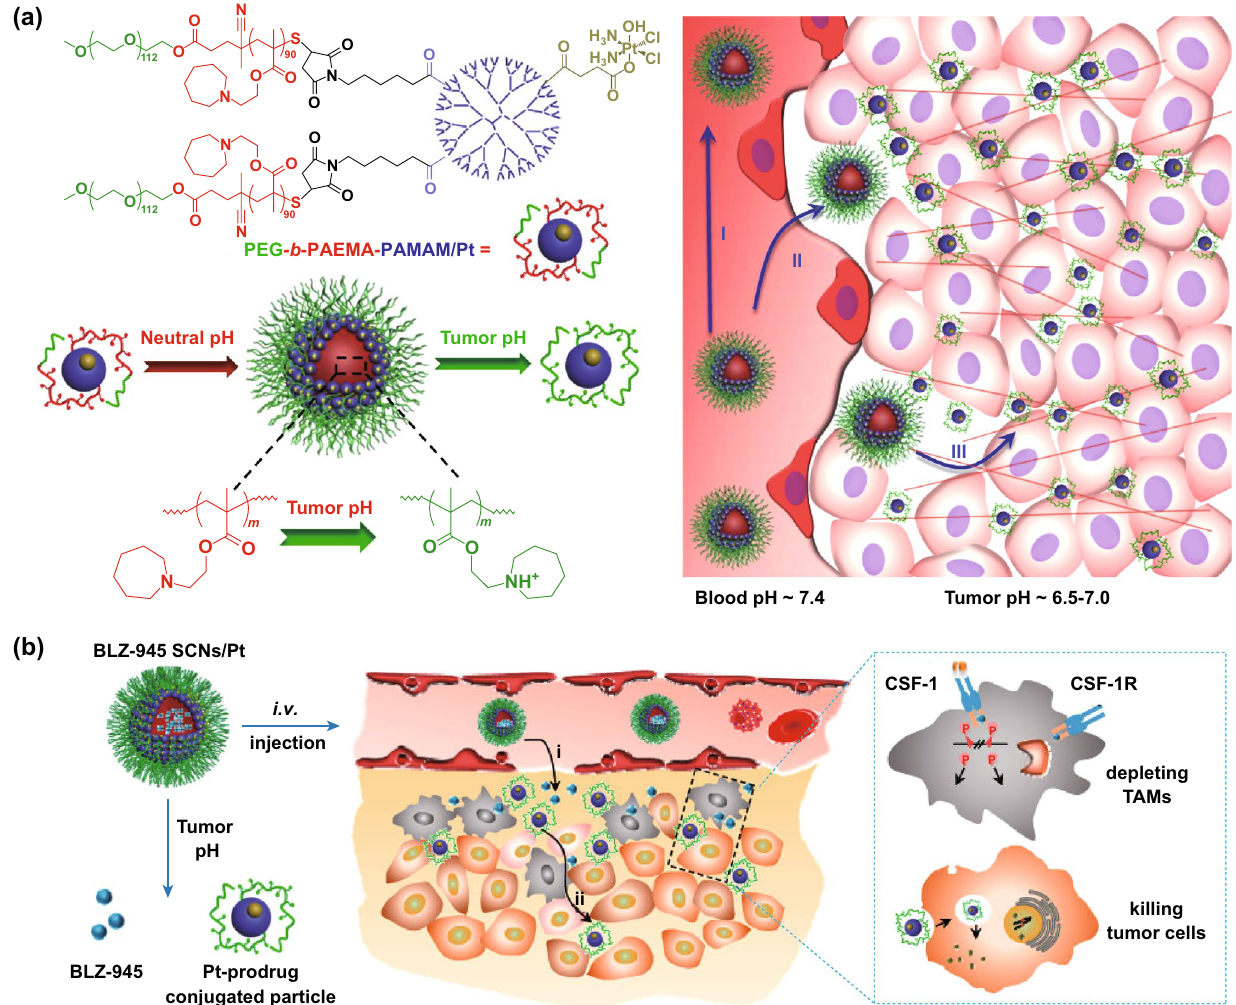
Fig. 6 a Schematic illustration of PEG-b-PAEMA-PAMAM/Pt, reproduced with permission from Ref. [138]. Copyright 2016 American Chemi- cal Society. b Mechanism of spatial delivery of BLZ-945 and Pt-prodrug to TAMs and tumor cells. Reproduced with permission from